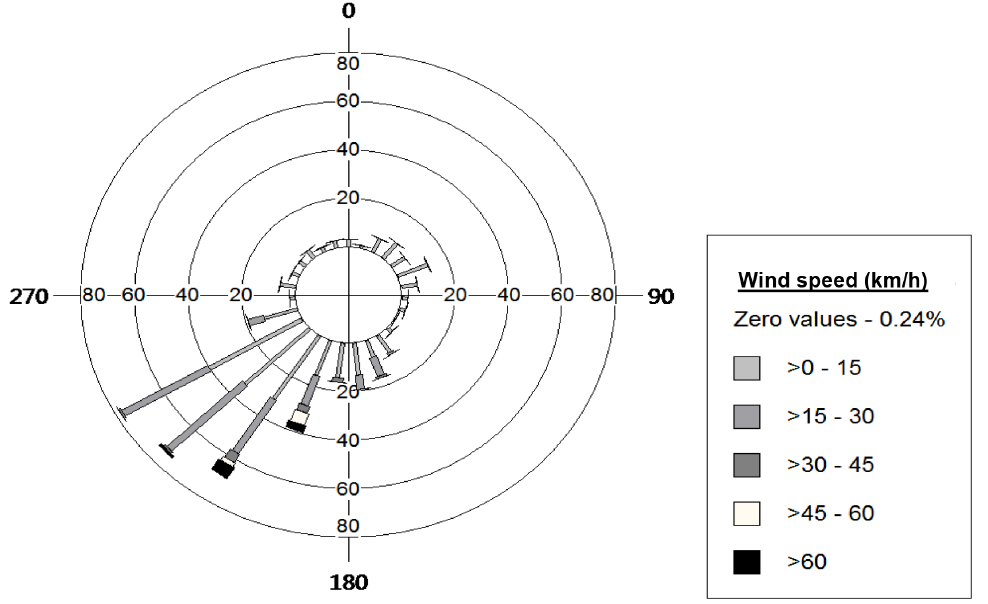
Figure 3. Wind direction ( u ) by wind speed (km/h). Ground-based wind direction and wind speed for observation hours (417 hours) over three fall migration seasons between 30 September –24 October, 2009–2011 at the Dokie 1 Wind Energy Project, BC, Canada.